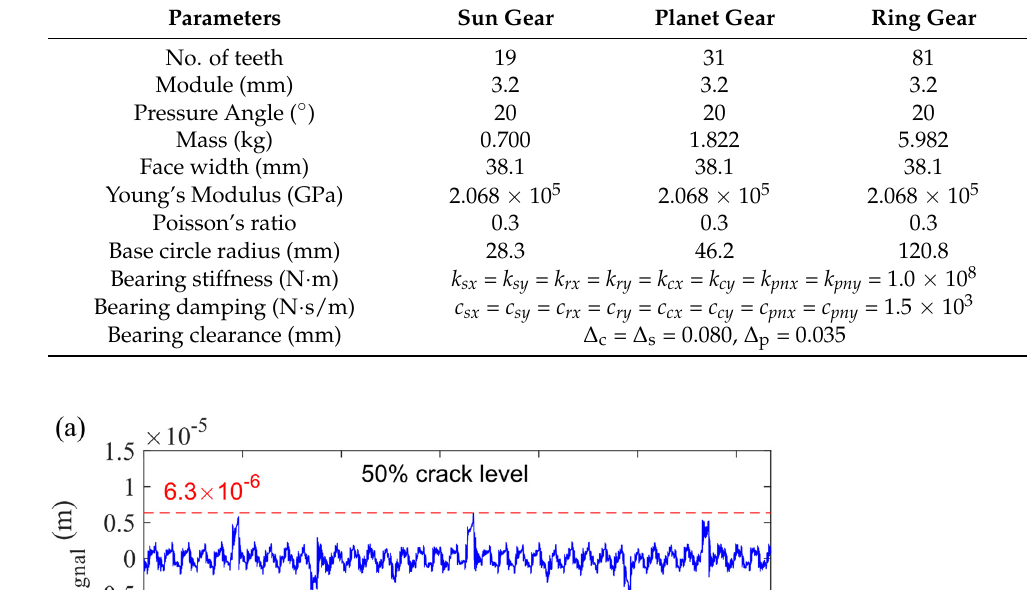
Table 4. Parameters of the modeled planetary gearbox [29].